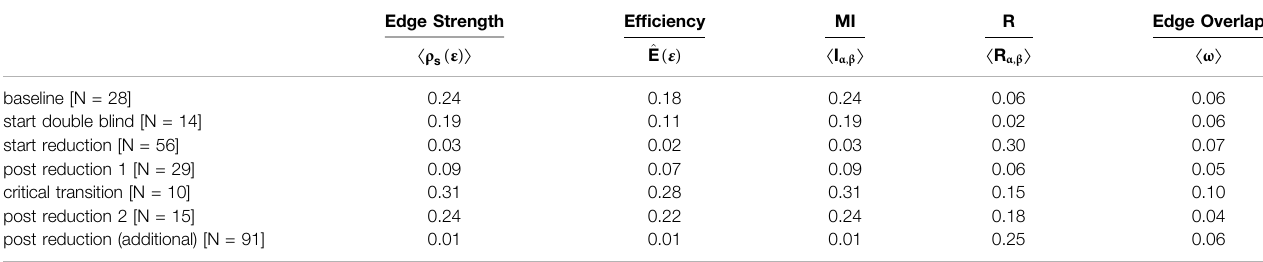
Edge Strength Ef fi ciency MI R Edge Overlap ( ε ) 〉 〈 ρ s